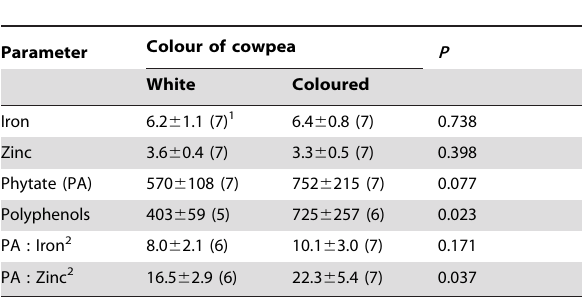
Table 3. Comparisons of iron, zinc, phytate, polyphenol and phytate-to-mineral composition of white and coloured landraces of cowpeas locally available in northern